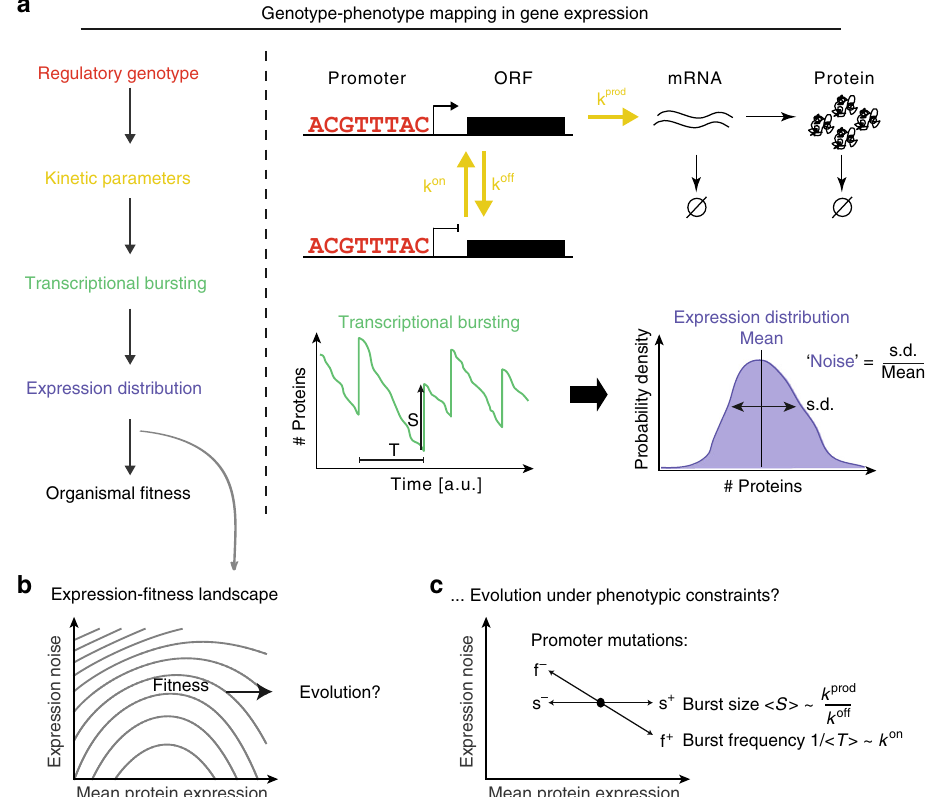
Fig. 1 Genotype-phenotype mapping in expression and its link to organismal fi tness. a Multi-level mapping from regulatory genotype to expression phenotypes to organismal fi tness. Regulatory genotypes (red) determine kinetic parameters (e.g. promoter on/off switching k on / k off , rate of mRNA transcription k prod , yellow), thus the properties of transcriptional bursting (average size < S> and frequency 1/ <T> , green), which results in particular protein expression distributions (blue). Expression distributions, characterized by their mean and noise (normalized standard deviation, i.e. coef fi cient of variation), determine organismal fi tness via the expression- fi tness landscape (panel b ). b The expression- fi tness landscape (contours depict equi- fi tness levels) describes the mapping between the expression distribution of a gene (i.e. its properties mean and noise) and fi tness. Quantifying the topology of expression- fi tness landscapes may inform about the evolution of gene expression systems. c The transcriptional process constrains how genetic variation can move gene expression in mean-noise space; e.g. promoter mutations cannot lead to purely vertical moves (i.e. only changing noise). Does this affect the evolution of gene expression